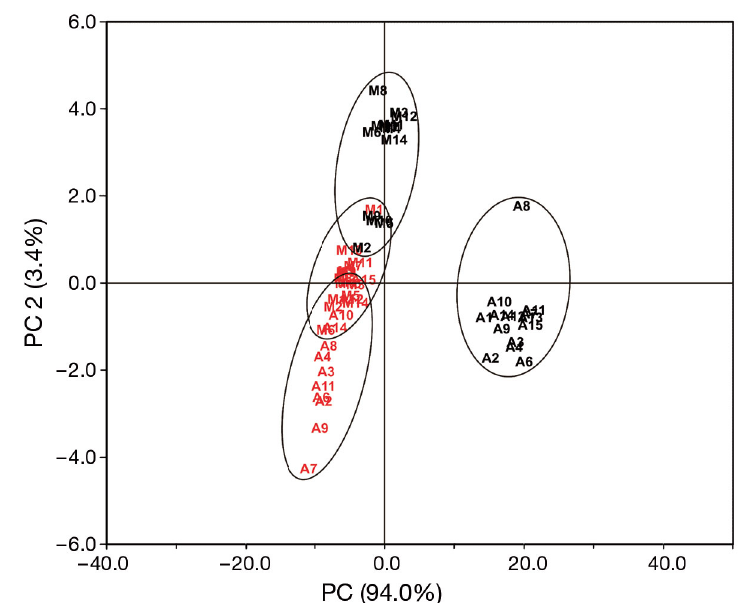
Fig. 1. Salmo salar . Score plot of principal component (PC) analysis of fatty acid methyl esters (FAME) in the muscle (M) and adipose fin (A) in farmed